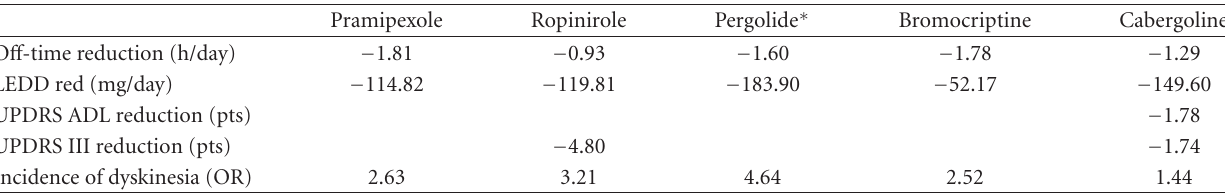
Table 2: Adjuvant therapy versus placebo.